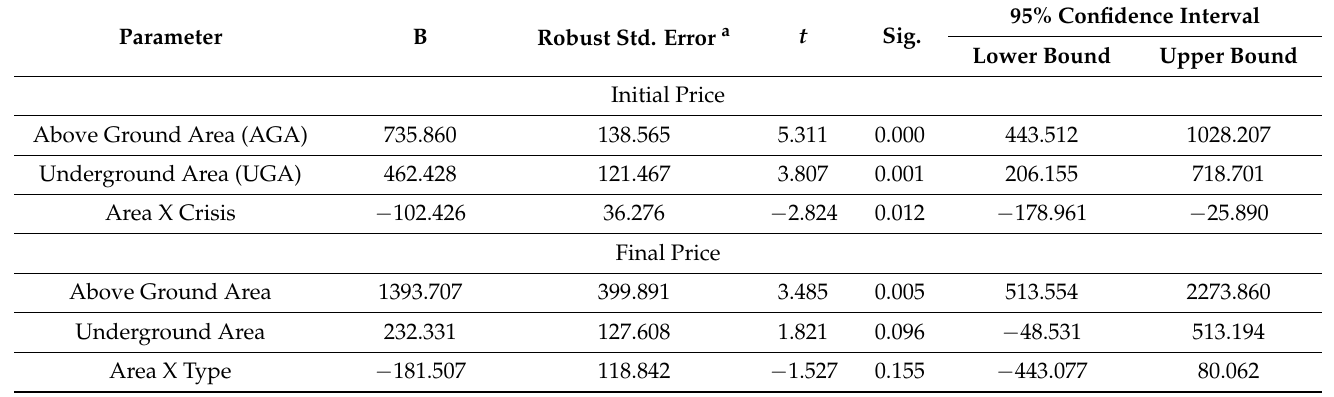
Table 6. Regression models for the initial and final price.